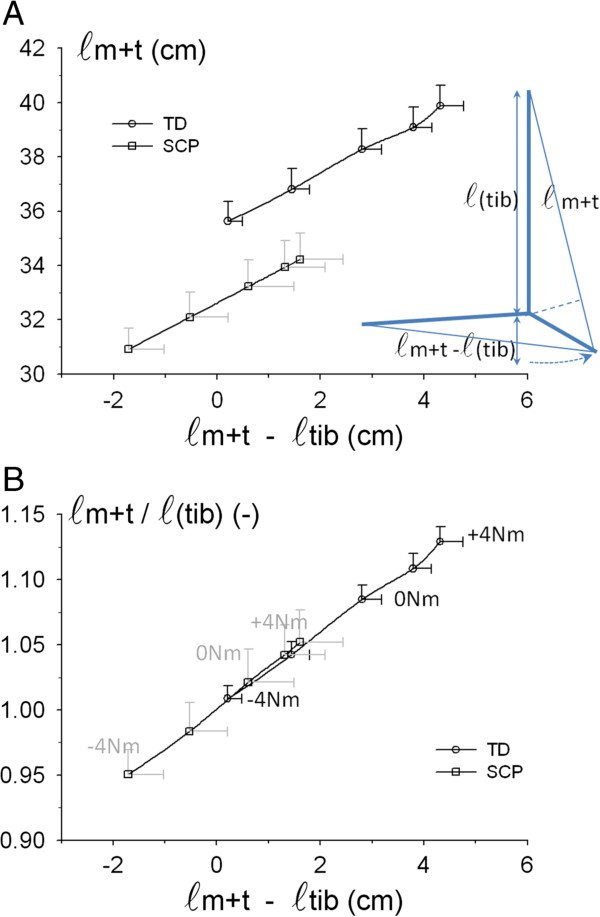
SCP-TD comparisons for absolute and normalized GM length. Inset: Schematic illustrating the concept of GM relative length with respect to tibia length (ℓm+t -ℓ(tib)) as a (co-)determinant of ankle joint angle. A. Absolute GM muscle-tendon complex length (ℓm+t). B. GM muscle-tendon complex length normalized for tibia length (ℓm+t/ℓ(tib)) GM relative length (ℓm+t -ℓ(tib)), as estimate of talocrural joint angle changes, is plotted as independent variable. For a number of data points the external moment applied to attain such positions is indicated (black font for TD and gray font for SCP, respectively). Additional statistical analysis was performed on fitted data for the overlapping GM relative lengths (i.e. equal lengths: +0.33 > ℓ(m + t)-ℓ(tib) < +1.61). Note that very different moments were applied externally for that range. Also note that GM in SCP generally operates at lower relative lengths. Mean values + SEM are plotted.